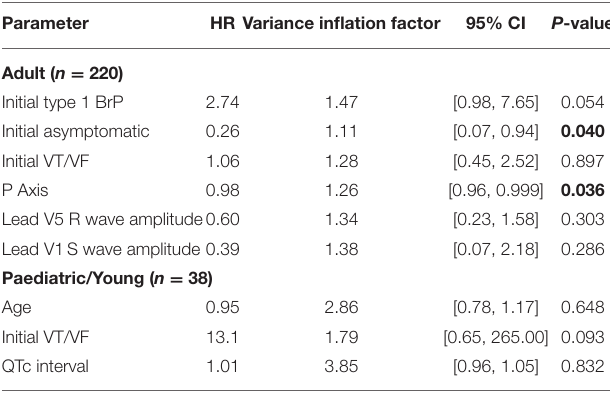
TABLE 2B | Multivariate predictors for post-diagnosis VT/VF-free survival in BrS including baseline ECG parameters.